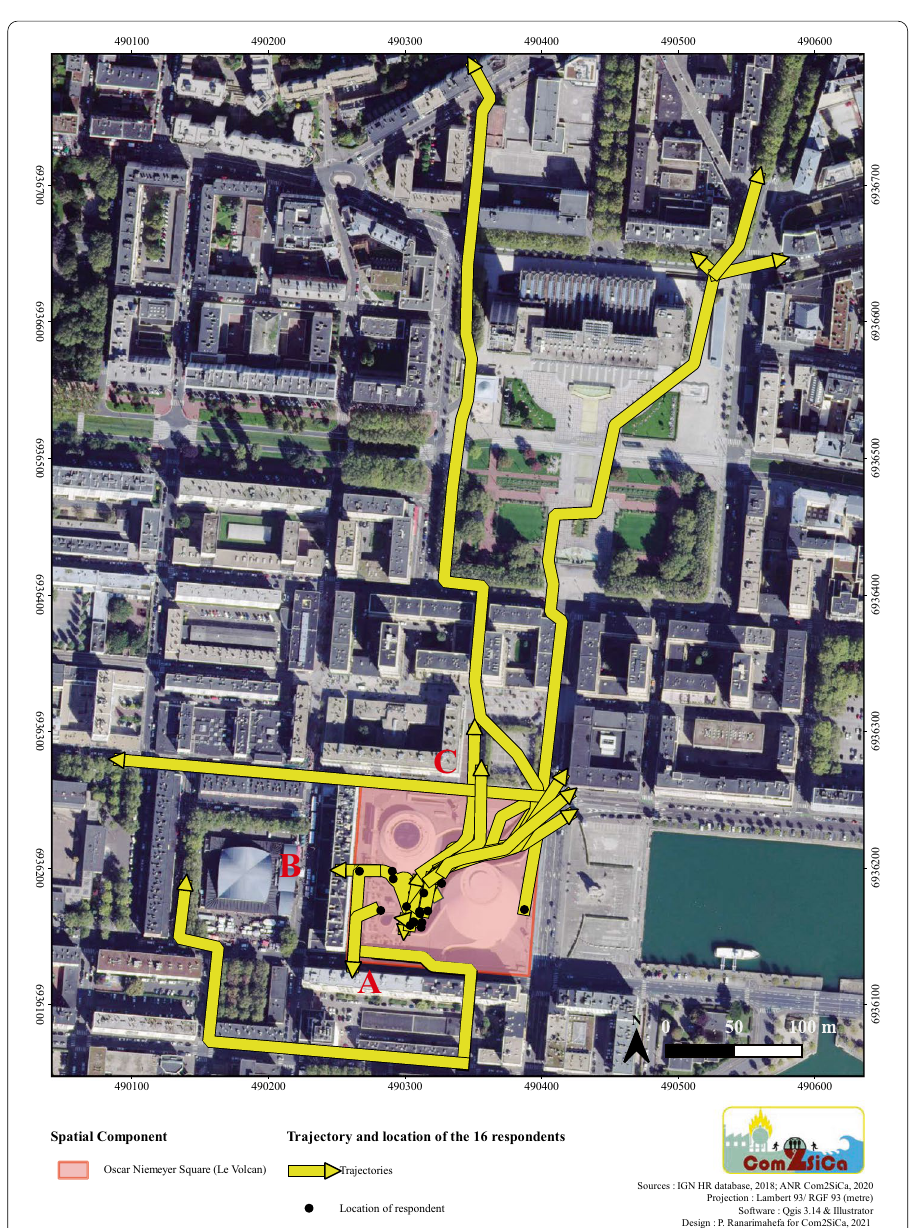
Fig. 3 Mapping of the trajectories chosen by people during the interviews around the Niemeyer Cultural Center. These trajectories have been extracted from geolocalized watches. Three main escape directions (noted A, B, and C, respectively, on the map) can be